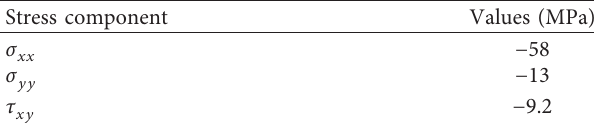
Table 2: The stress component used in numerical simulation. Stress